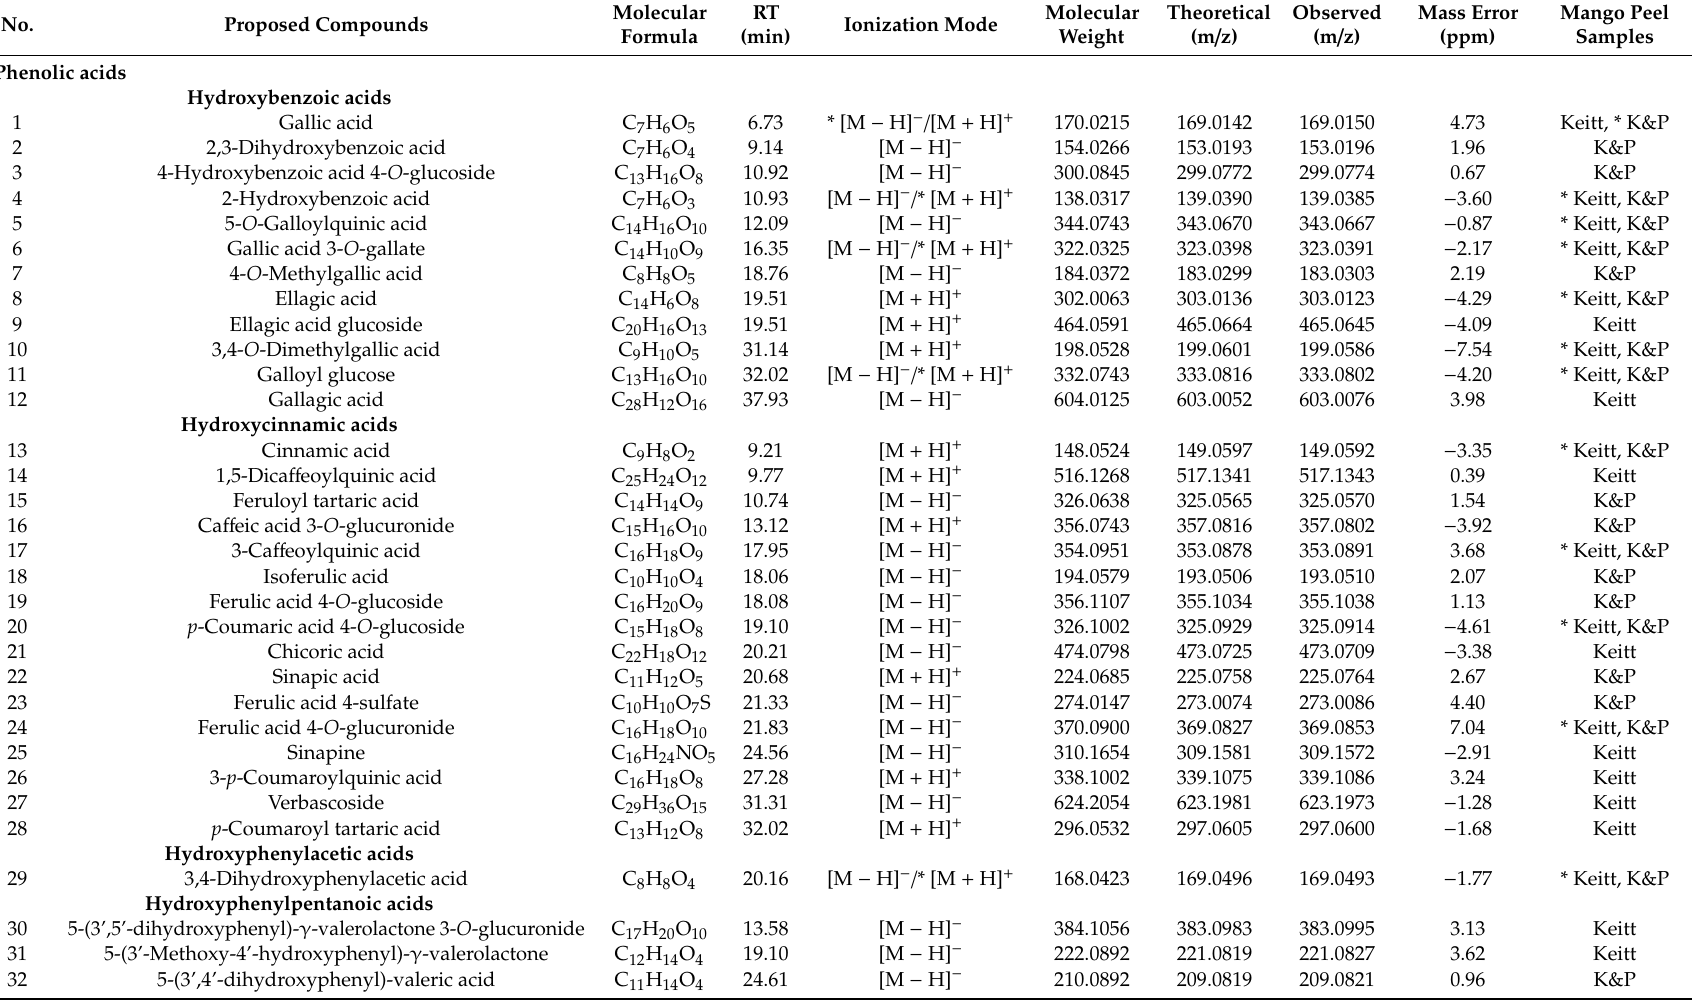
Table 2. Phenolic compounds detected and tentatively characterized in mango peel extracts by using liquid chromatography coupled to electrospray ionisation and quadrupole time of flight mass spectrometry (LC-ESI-QTOF-MS) in positive and negative ionisation